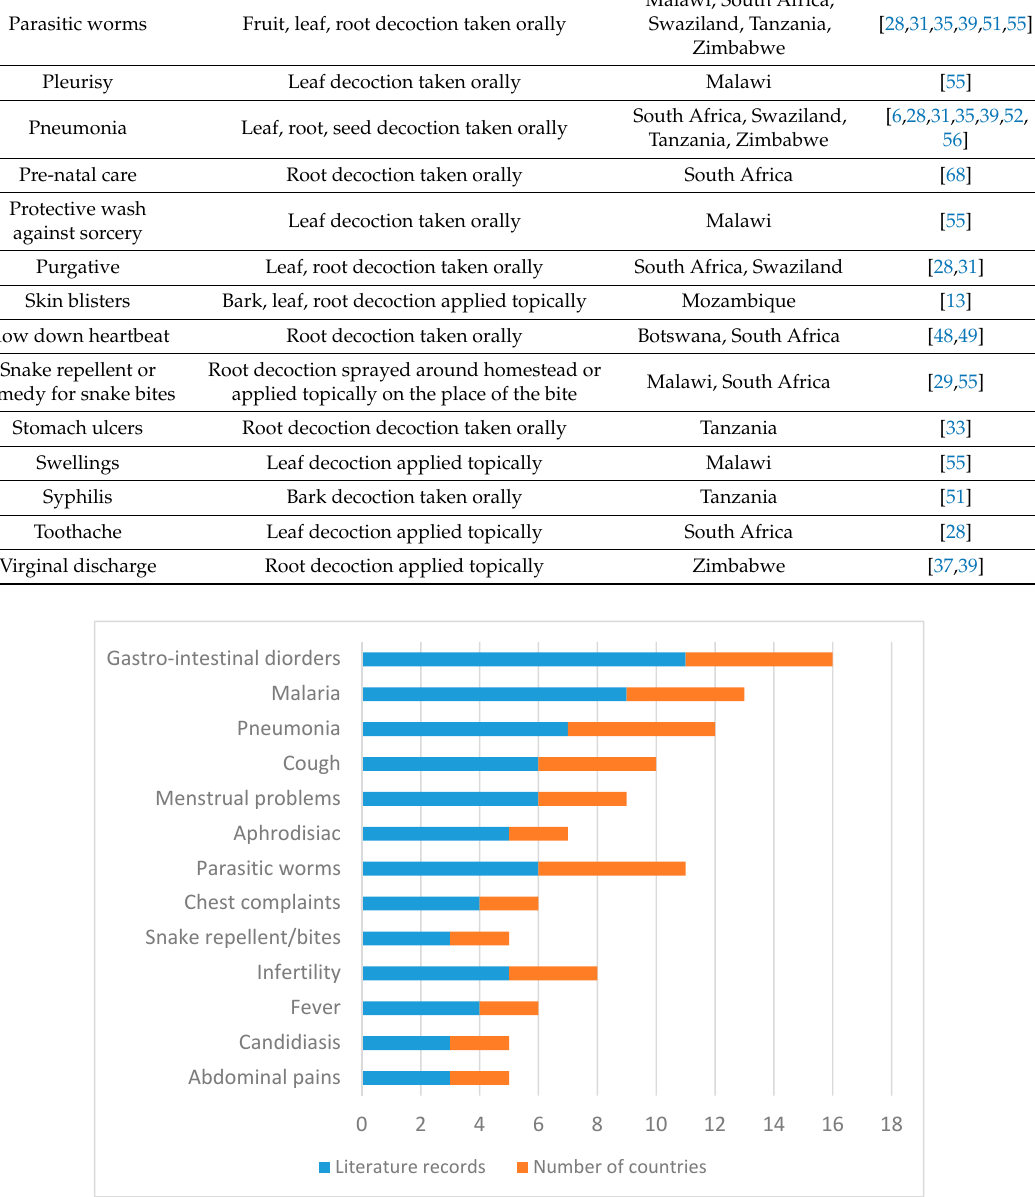
Figure 3. Diseases and ailments treated by Vangueria infausta subsp. infausta in east and southern Africa.